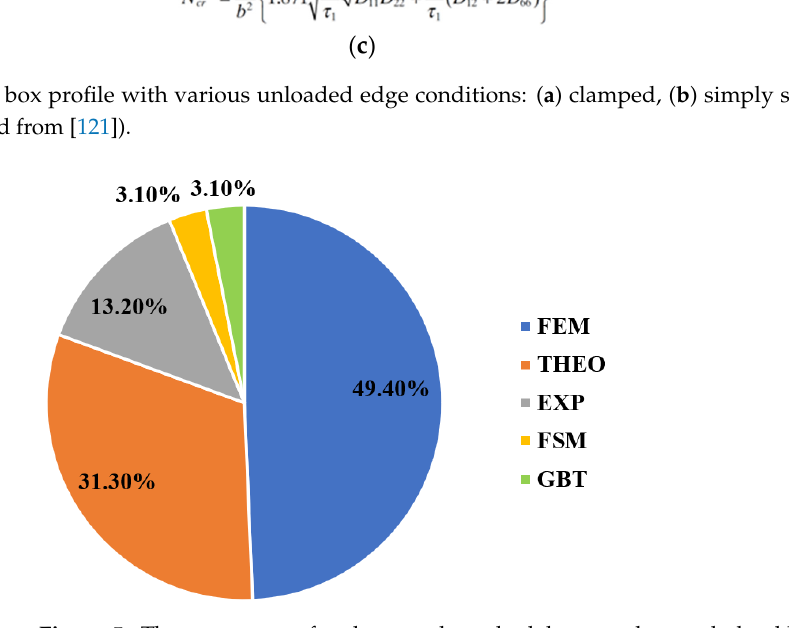
Figure 5. The percentage of each research methodology used to study local buckling and its param-